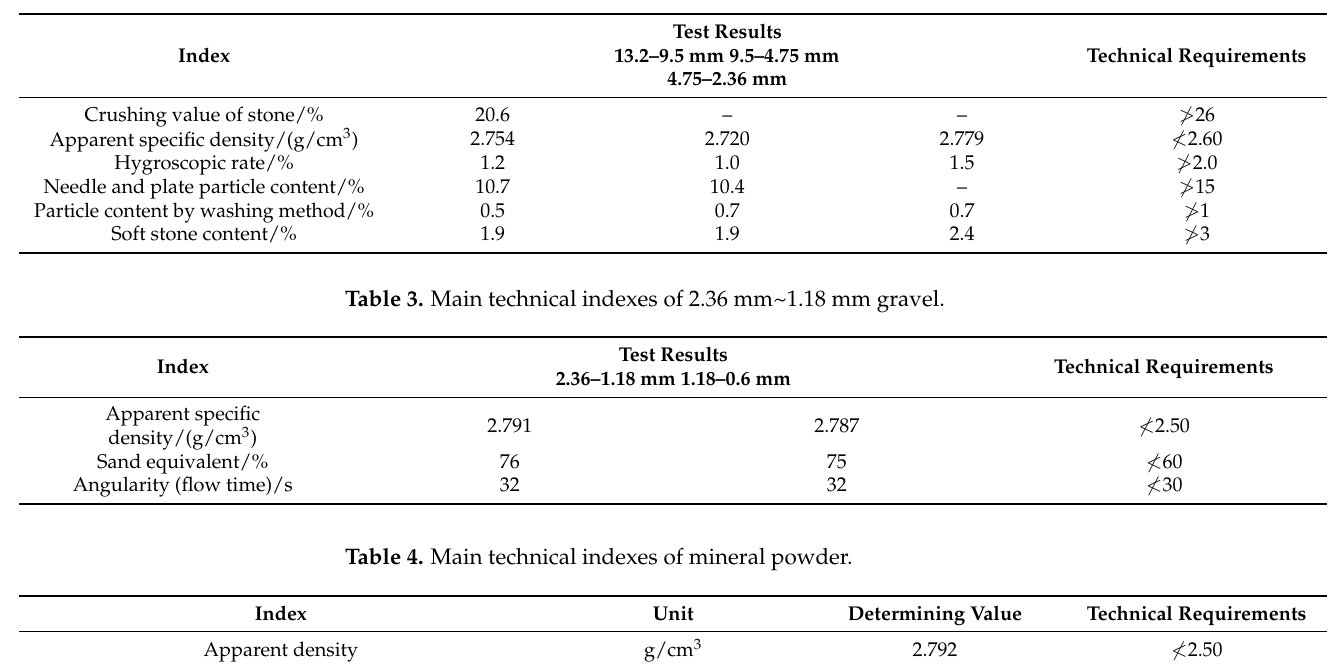
Table 2. Main technical indexes of 13.2 mm~2.36 mm gravel.